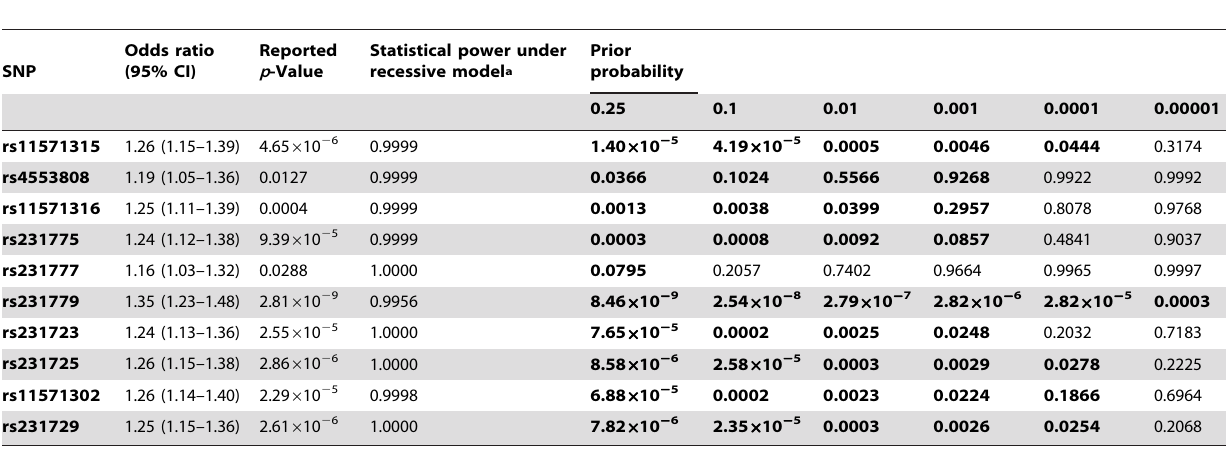
Table 4. False positive report probability (FPRP) values for ten SNPs with significant difference between 2640 patients with GD and 2204 health